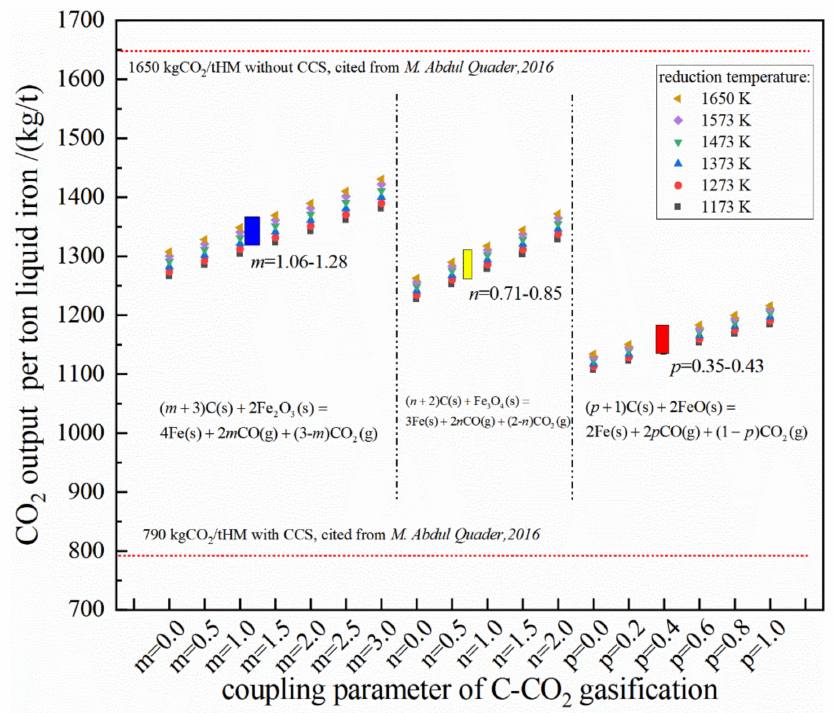
Figure 19. The CO 2 output per ton of liquid iron of varied coupling